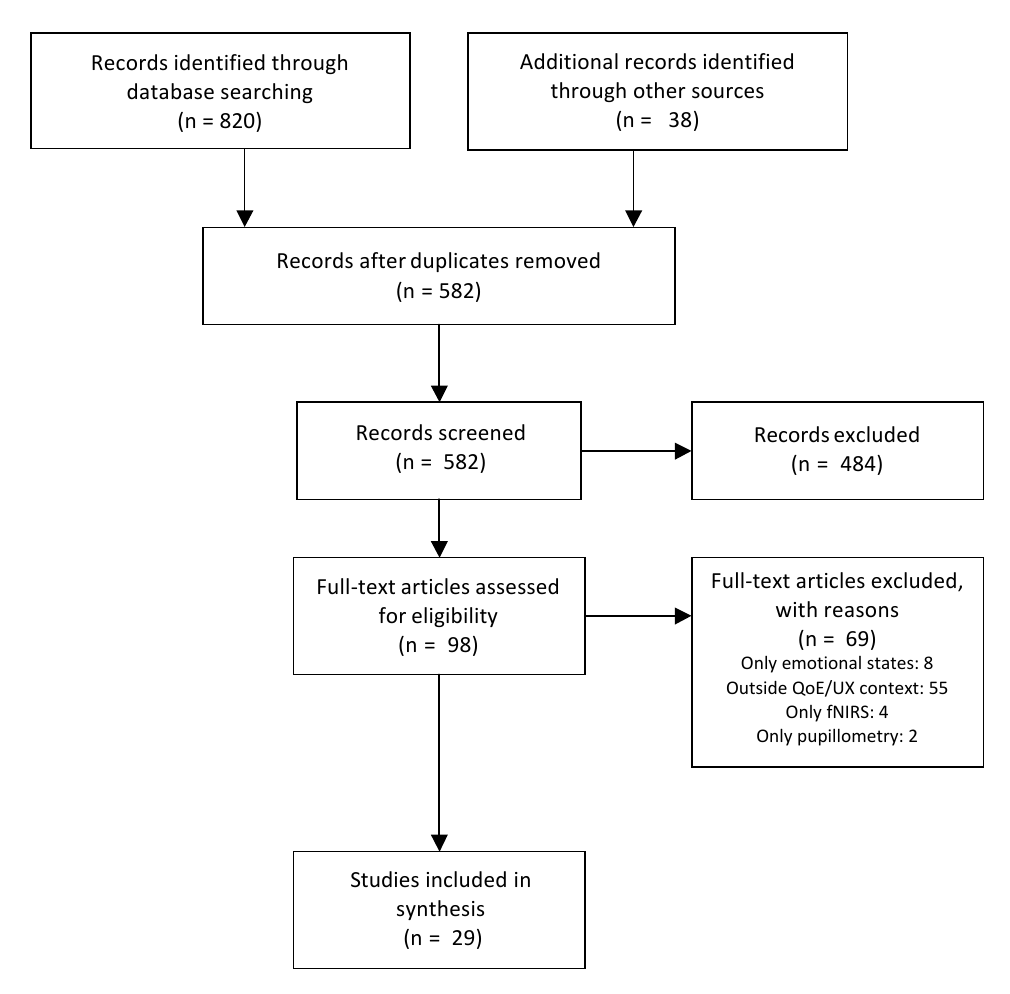
Figure 1. Flow diagram showing the process for papers’